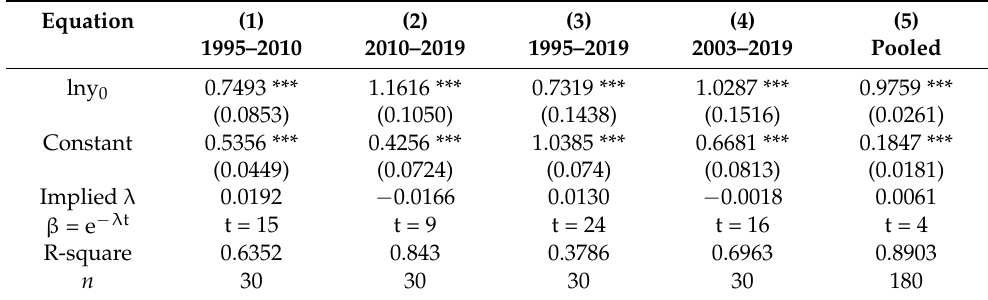
Table 2. Absolute Convergence Test of Cross-Sectional